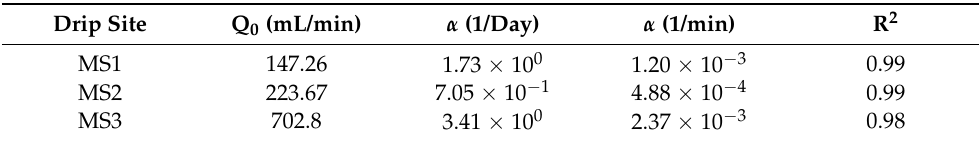
Table 3. Master recession curve results using the matching strip method for optimal fit over full drip record (2008–2018), Q 0 = discharge at the beginning of recession.